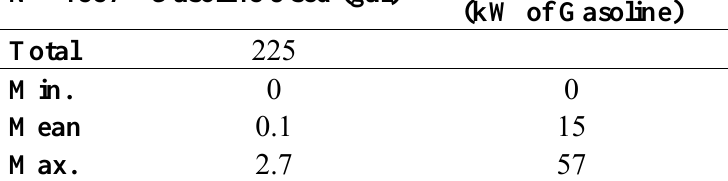
Table 7. Driving energy